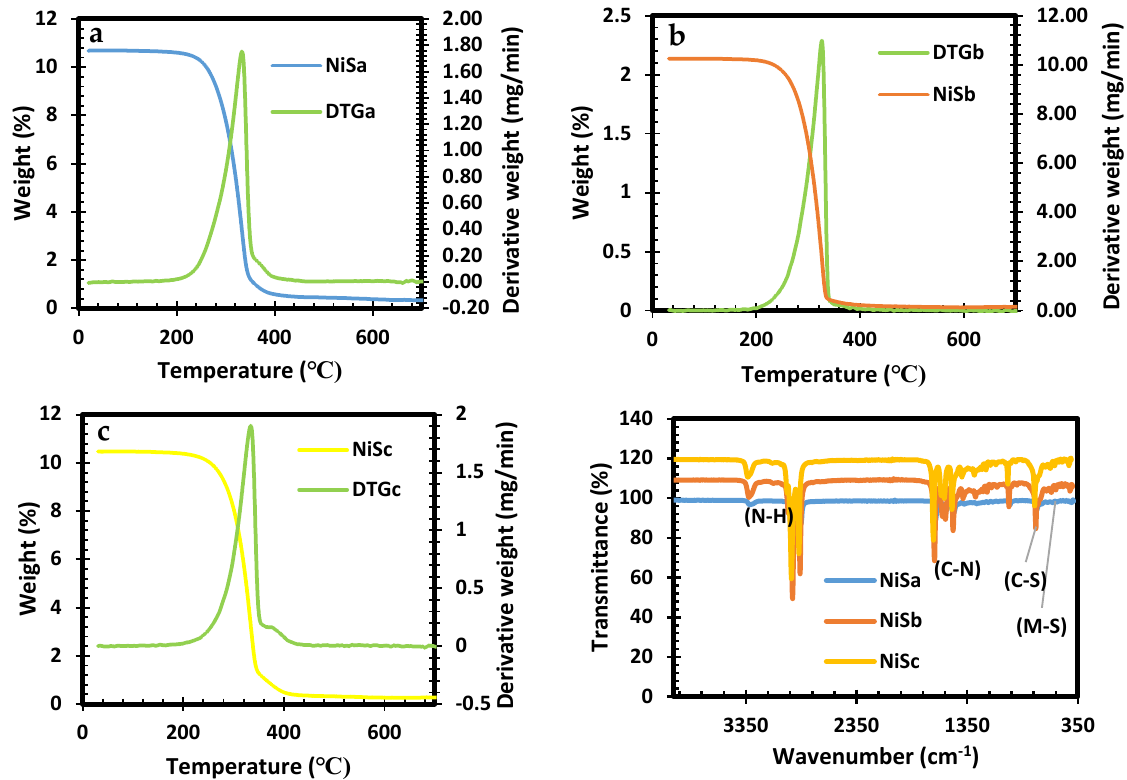
Figure 1. TGA ( a – c ) of [Ni[ N , N -benz- N - p -anisldtc], [Ni[ N , N -benzldtc], and [Ni[ N - p -anisldtc] com- plexes as NiSa, NiSb, and NiSc and FTIR spectras ( d ) of NiSa, NiSb, and NiSc